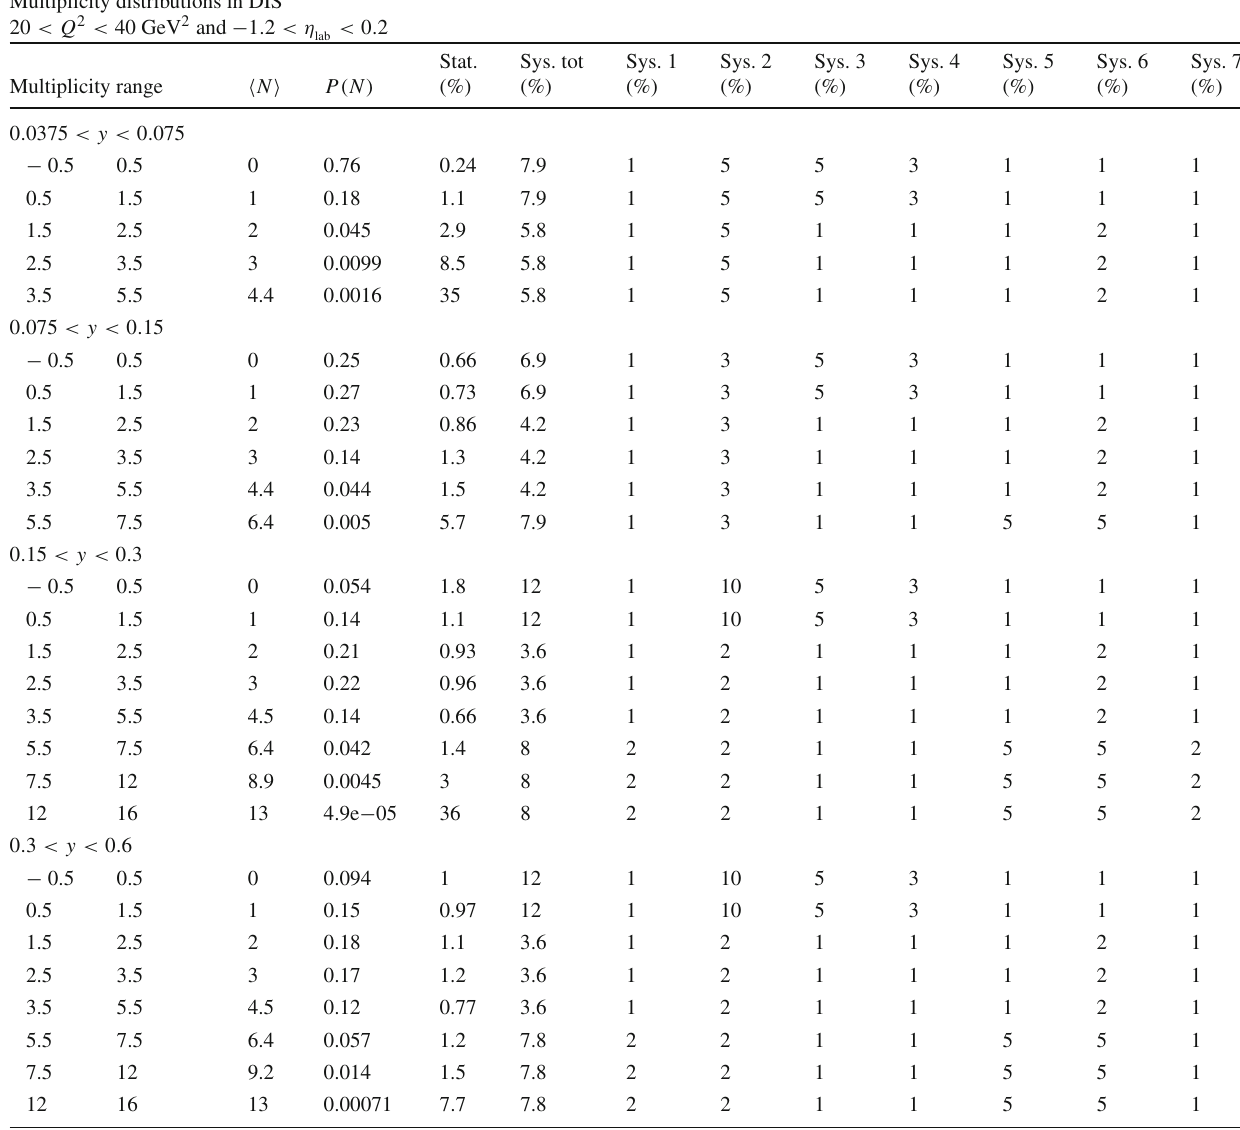
Table 19 Charged particle multiplicity distributions P ( N ) measured √ s = 319GeV with in the ranges of photon virtual- in ep DIS at ity 20 < Q 2 < 40 GeV 2 and charged particle pseudorapidity range Multiplicity distributions in DIS < 0 . 20 < Q 2 < 40 GeV 2 and − 1 . 2 < η lab